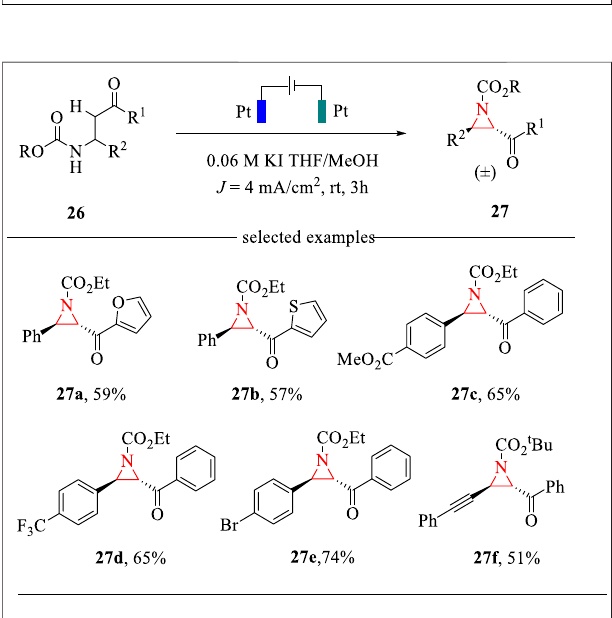
SCHEME 9 | The electrochemical synthesis of